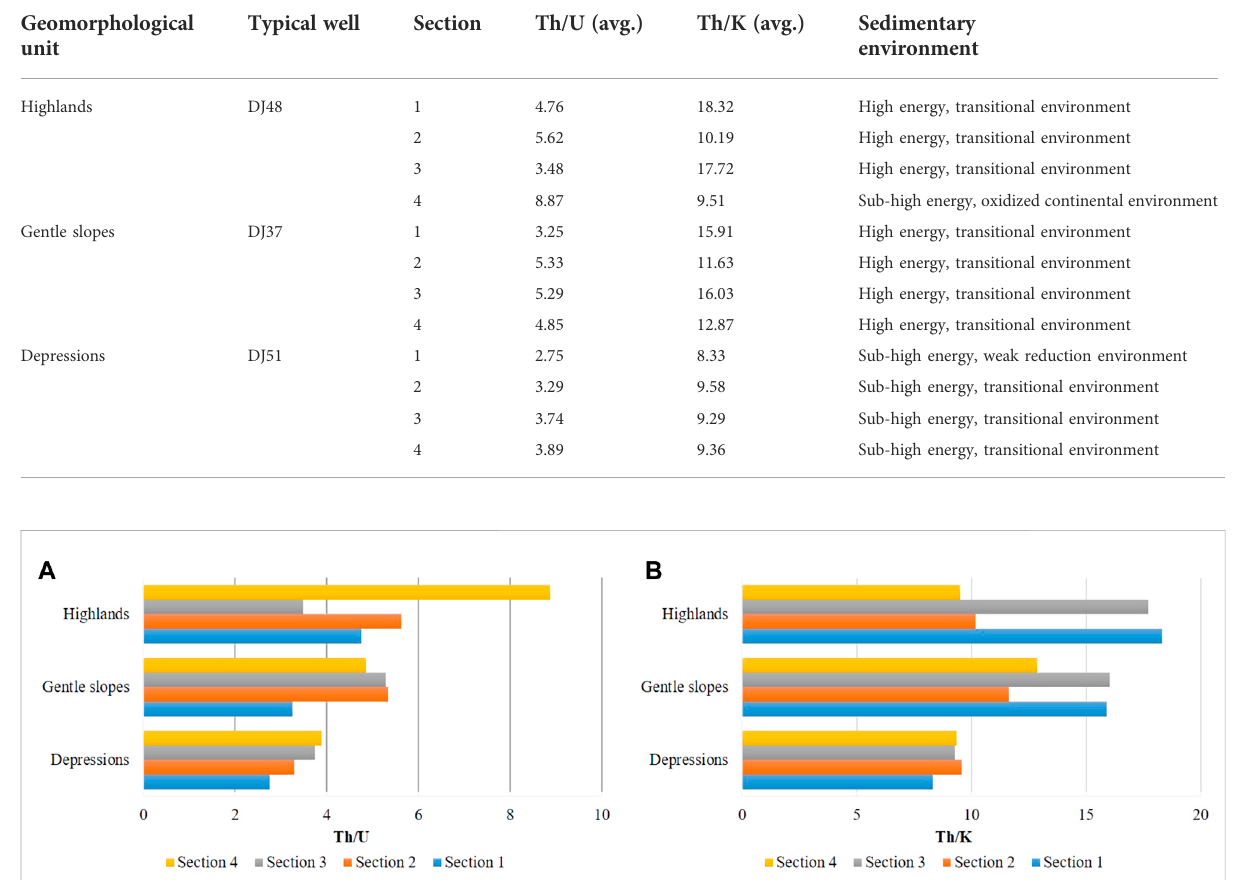
FIGURE 12 Th/U and Th/K variation characteristics of typical wells with different paleogeomorphology units of each section in the Shan-2 Lower Sub-